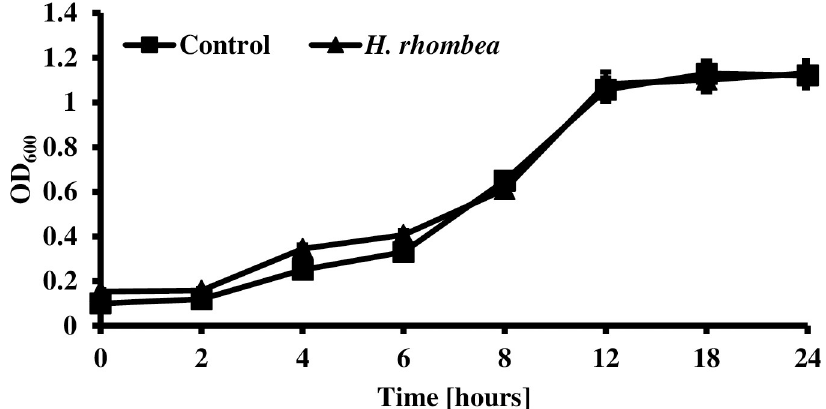
Fig 7. H . rhombea extract did not inhibit the growth of C . albicans . C . albicans (1 × 10 6 cells/mL) with 100 μ g/mL of H . rhombea extract were incubated at 30˚C for 24